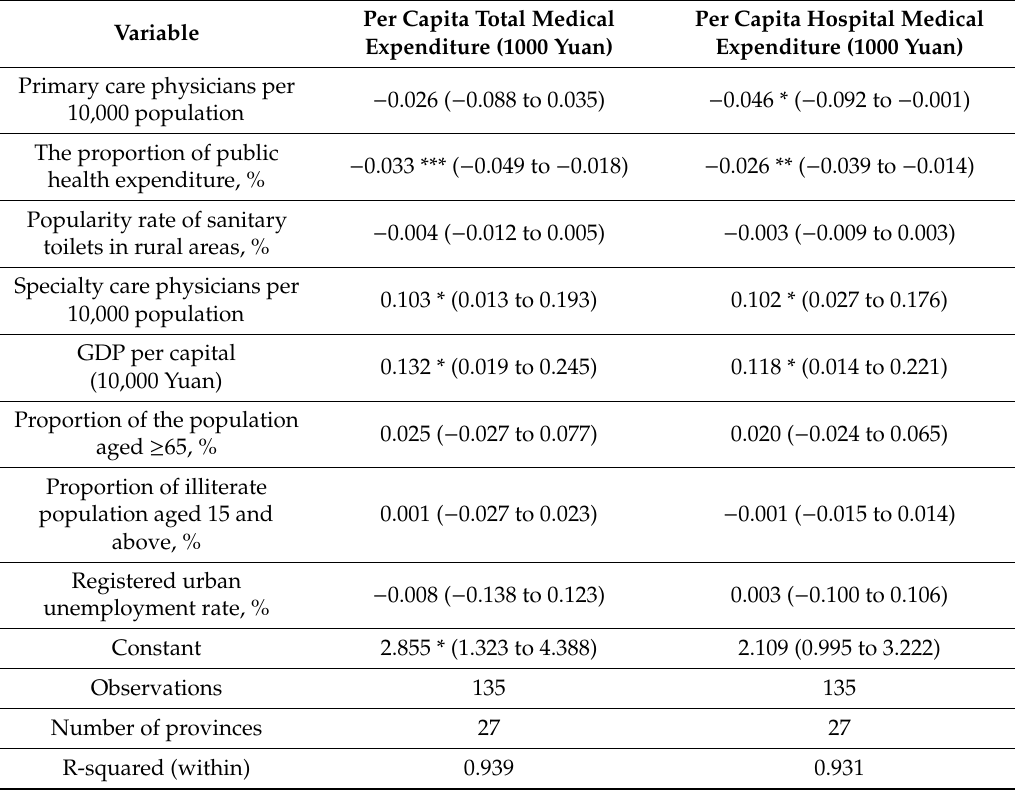
Table 2. Regression model results for the 27 provinces of China, 2012–2016.